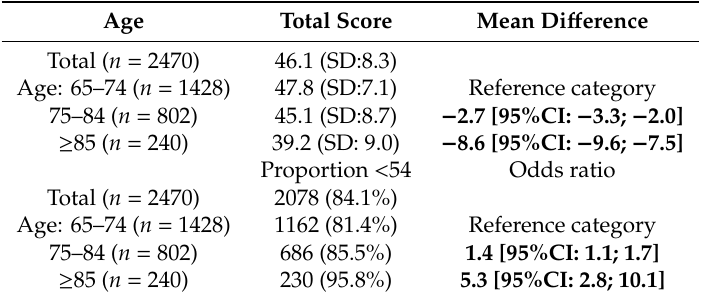
Table 1. Mean scores on SCREEN II and proportions < 54 point.